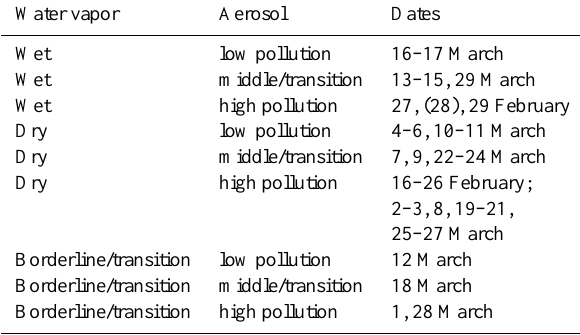
Table 1. Daily-averaged aerosol and water vapor conditions dur- ing CARDEX, indicating days of low (CPC < 1000cm − 3 ), high (CPC > 1500cm − 3 ), or intermediate or transitioning pollution con- ditions (1000 < CPC < 1500cm − 3 ). A “dry” classification indi- cates that total-column precipitable water vapor was less than 40kgm − 2 , and “wet” indicates PWV that was greater than 40kgm − 2 . “Borderline/transition” indicates that the daily average was within 40 ± 1kgm − 2 or that the PWV shifted significantly be- tween dry or wet conditions over the course of the 24h period (mid- night to midnight, MVT). There were 30 dry and 8 wet days during this period, corresponding to 37 dry- and 13 wet-condition flights. Flights on borderline/transition days may still be classified as wet or dry based on average values measured around the flight time (Ta- ble 2). Note that no water vapor data were available on 28 February, though they seem likely to be wet given the conditions of the previ- ous and following days. All flights are visualized in Fig.